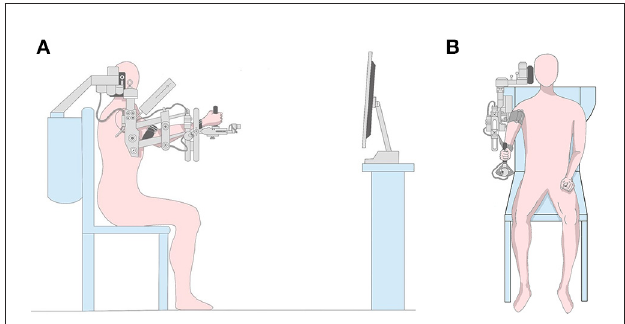
FIGURE1 Experimental setup. (A) Experimental setup from a sagittal view. The patient sat in a chair and two meters in front was a display screen. (B) Experimental setup from a coronal view. All parts of the affected limb were fixed and shoulder adductor abduction movement was performed in the task